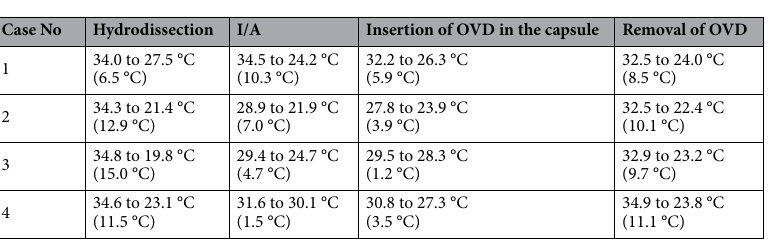
Figure 1. Intraocular temperature during cataract surgery in a typical case (Case #1 in Table 1). The series of procedures and time durations are indicated with the corresponding boxes and bars. The microscopic surgery images of procedures have been presented in the lower portion of the image. PEA: phacoemulsification and aspiration, I/A: irrigation and aspiration, OVD: ophthalmic viscosurgical device, IOL: intraocular lens.